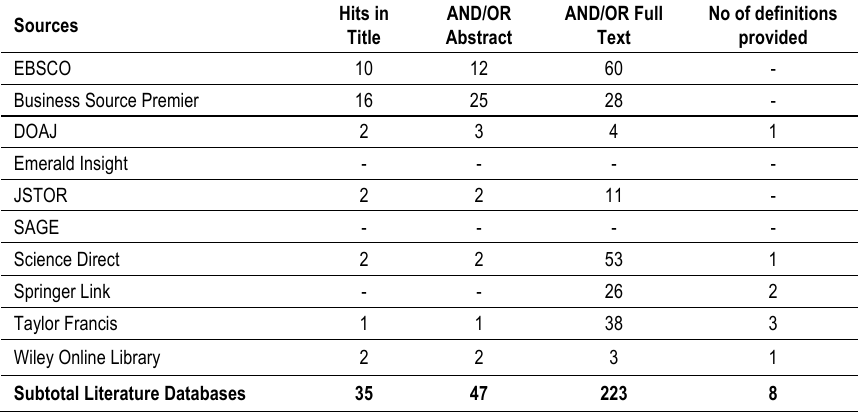
Table 1. Counts of the word Fintech in